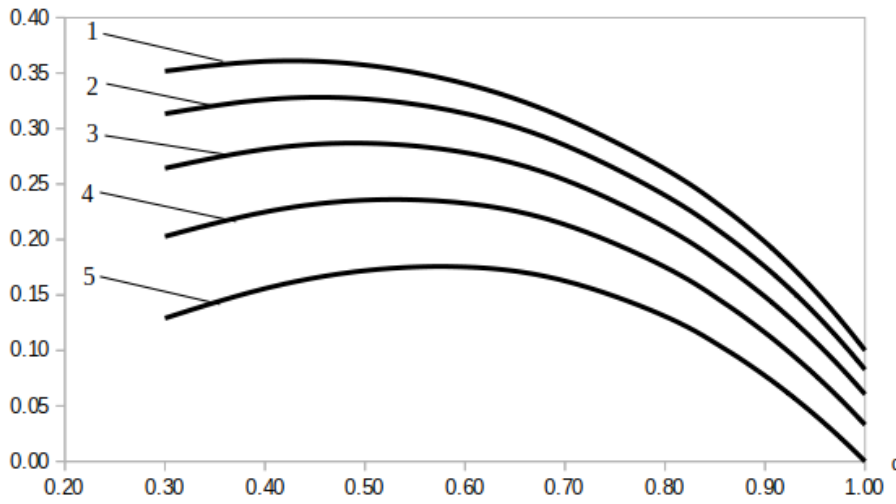
( α , γ ) subject to the value of the parameter α for: (1) γ = 0.8; RE